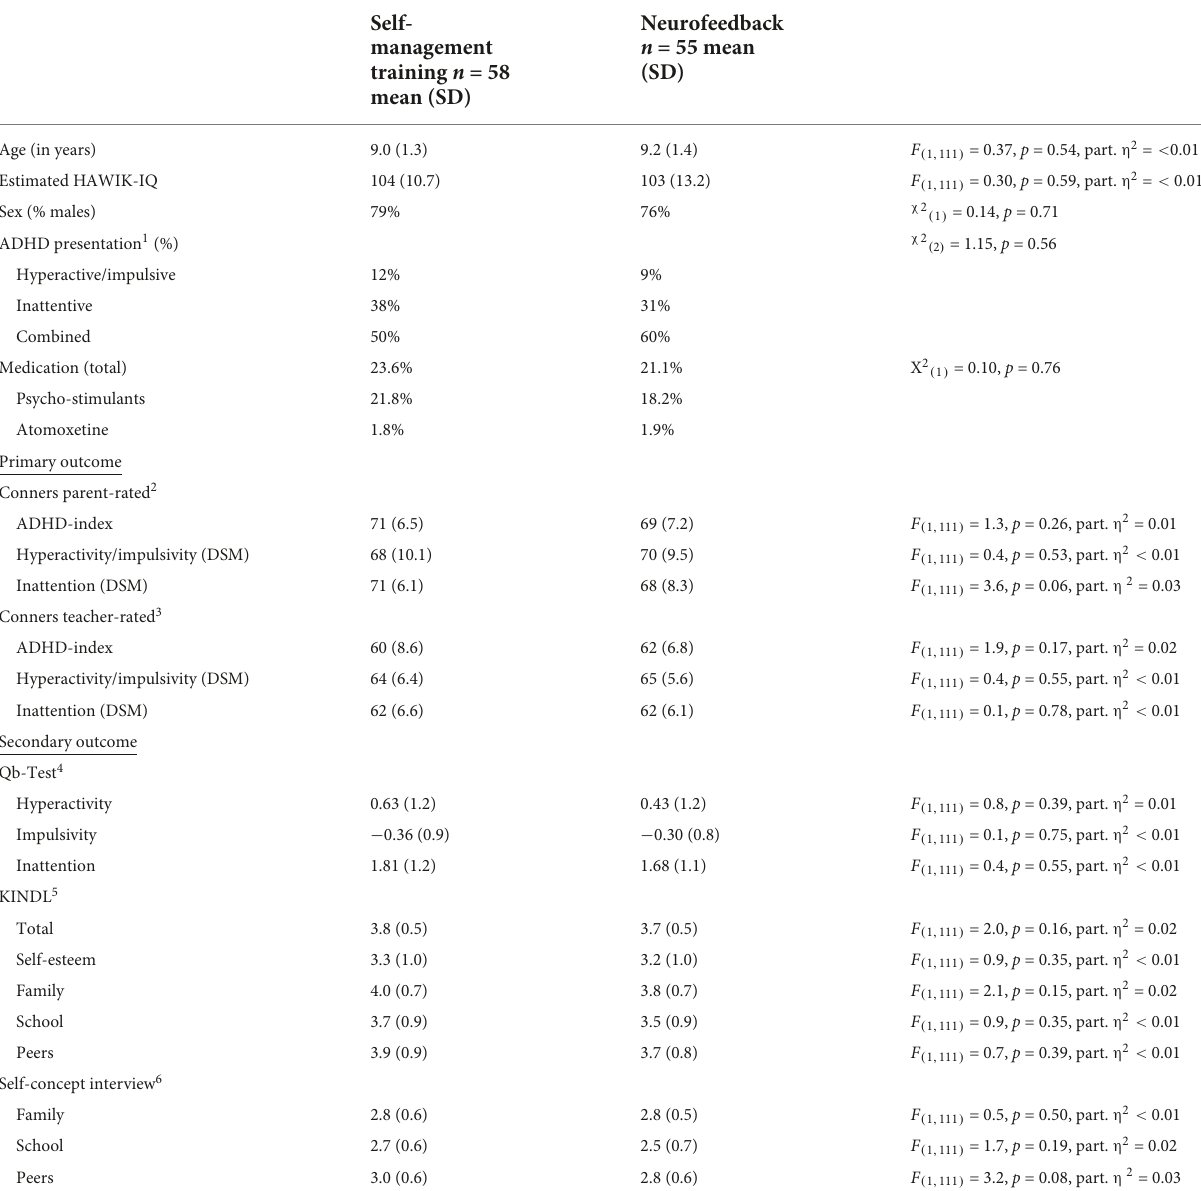
TABLE 1 Sample characteristics at baseline (T1,